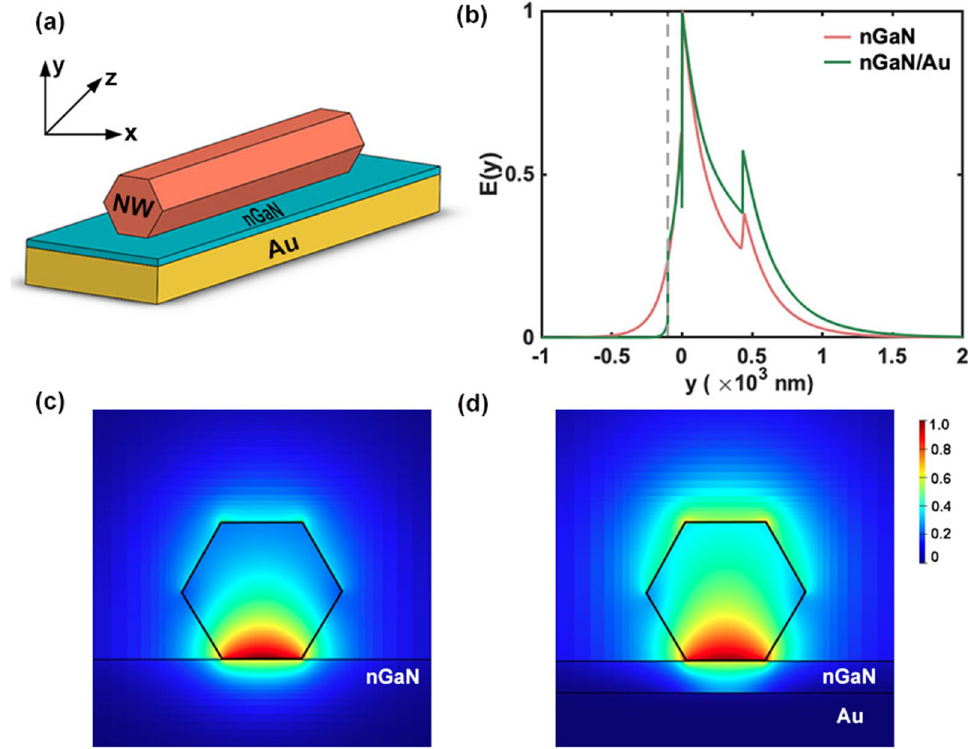
Fig. 6 a Schematic structure of the nGaN/Au-based NW laser. b Electric field magnitude distribution of nGaN and nGaN/Au-based NW lasers along the direction perpendicular to the substrate surface. The transverse electric field distributions of these plasmonic NW lasers are c and d , respectively